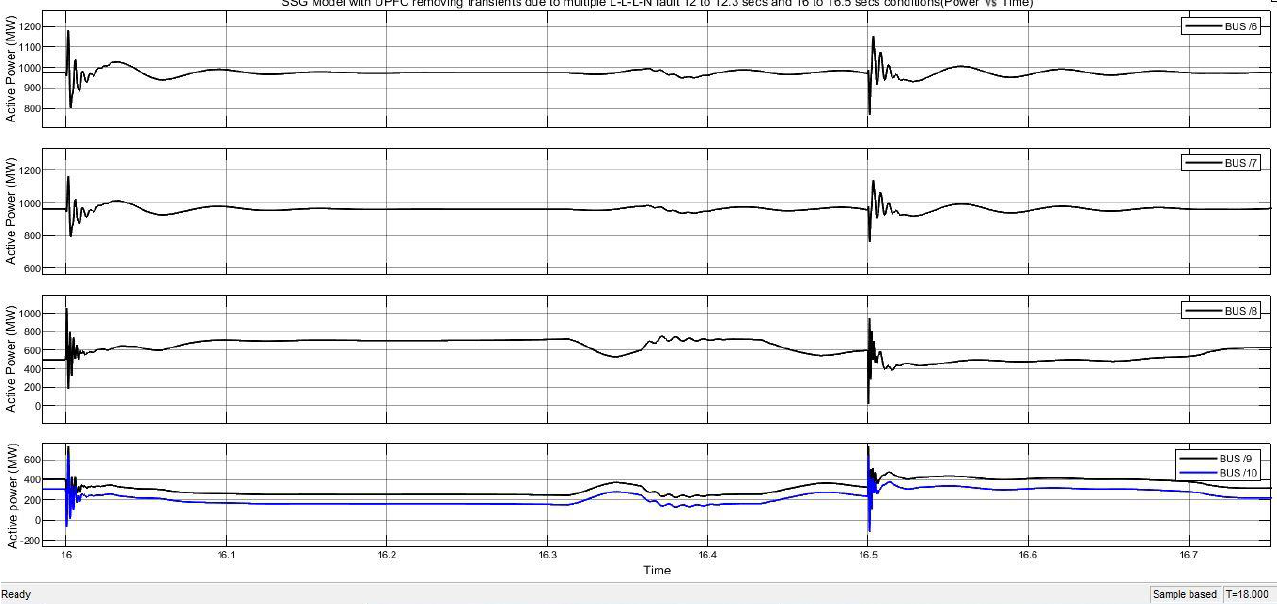
Figure 38. Transient stability being provided by UPFC after multiple L-L-L faults are introduced at 16 to 16.5 s (Bus 6 to Bus 10).